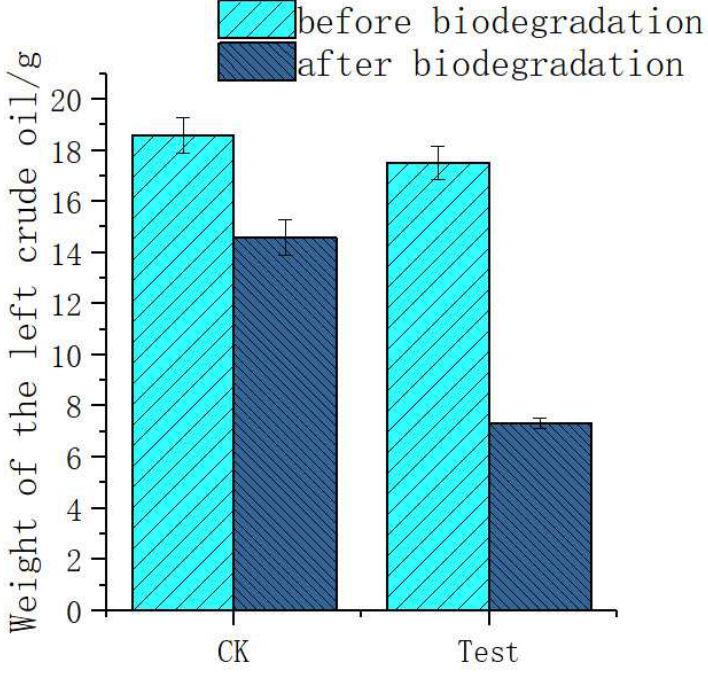
Figure 3. Comparison of the residual oil content before and after